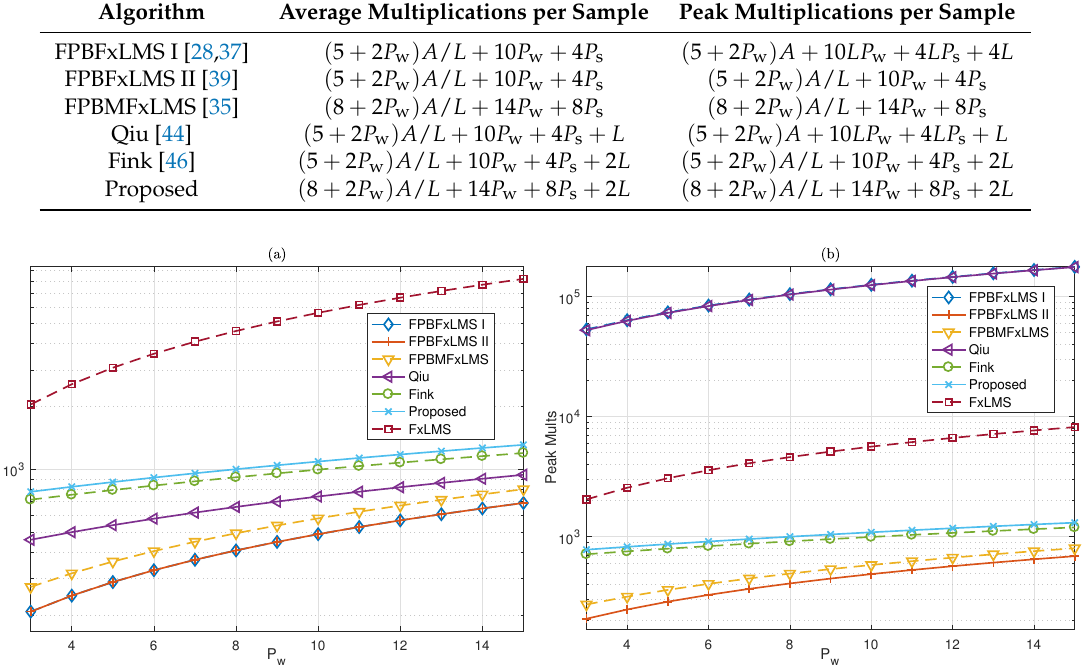
Figure 6. Peak and average complexities. ( a ) Average multiplications per sample. ( b ) Peak multiplications per